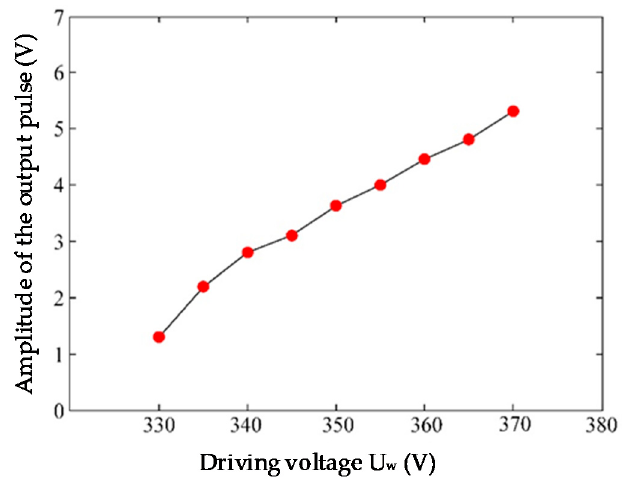
Figure 5. Output pulse amplitude under different drive voltages (R 3 = 10 k Ω , C 2 = 1000 pF).